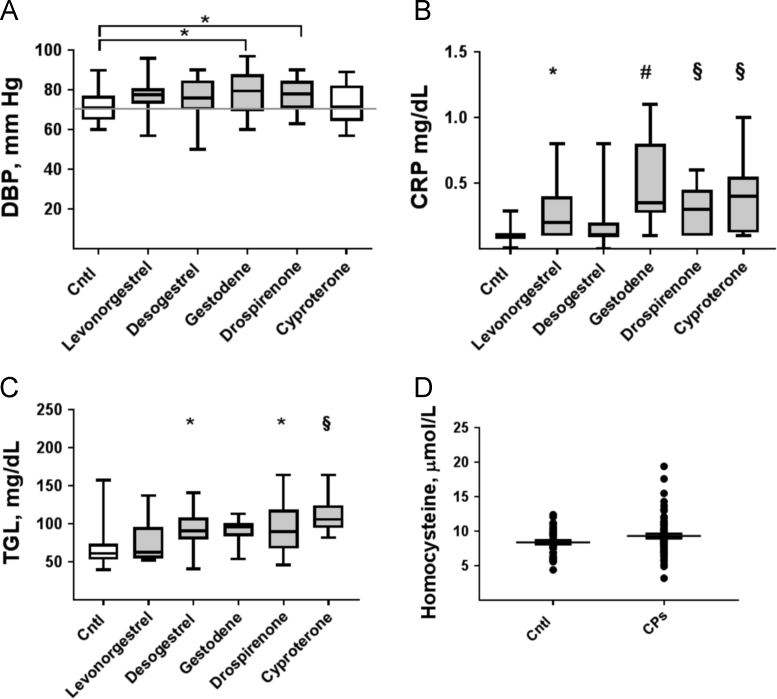
Clinical and biological characteristics of the study cohort. A. Diastolic arterial blood pressure (DBP); B. levels of C-reactive protein (CRP) and C. triglycerides (TGL) in control (Cntl) subjects and users of CP containing ethinyl estradiol and different types of progestogens: levonorgestrel (n=11), desogestrel (n=15), gestodene (n=10), drospirenone (n=17) and cyproterone (n=8). D. Levels of homocysteine in Cntl subjects and CP users (n=43, and n=71, respectively); * P<0.05; §P<0.01; #P<0.0001 compared by t-test or one-way ANOVA with Bonferroni׳s (A); or Dunn׳s (B and C) corrections for multiple comparisons to Cntl (no significant difference between different progestins).